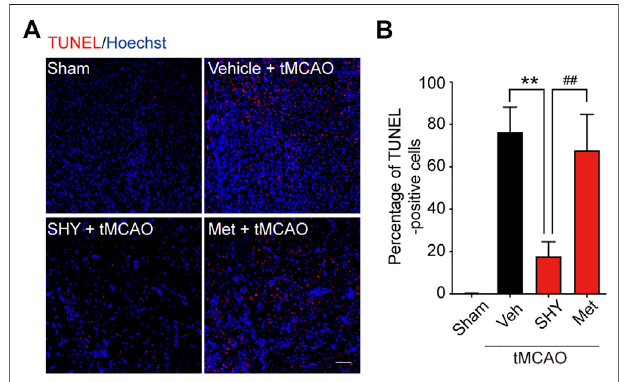
were determined with ImageJ software and statistical analysis were presented. Data are expressed as mean ± SD, n = 5, statistical analysis was performedwithone-wayANOVAfollowedbyaDunnett ’ sposthoctests.** p